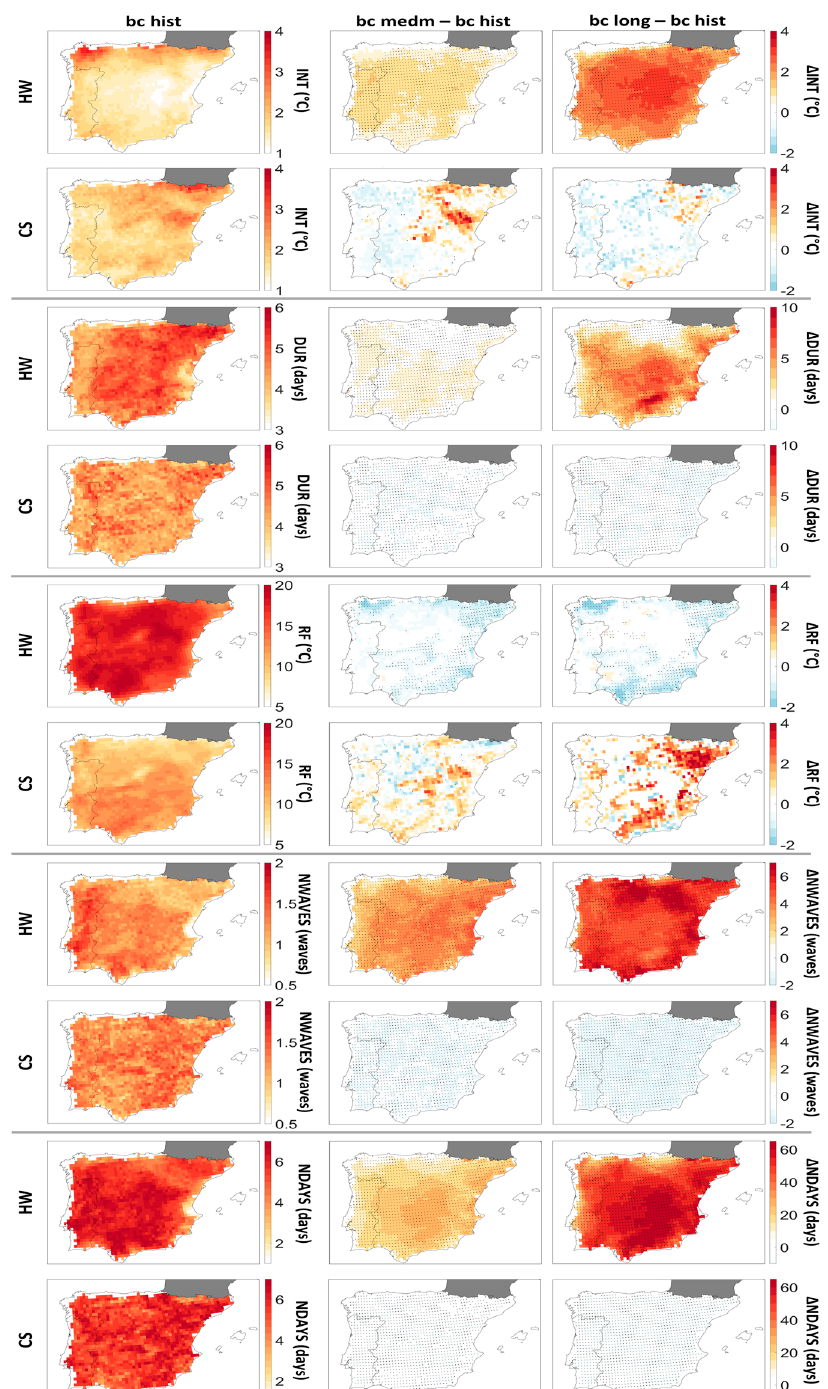
Figure 10. Mean properties—intensity (INT, ◦ C), duration (DUR, days), recovery factor (RF, ◦ C), waves’ / spells’ number (NWAVES), and number of wave / spell days (NDAYS, days)—of the heat waves (HW) and cold spells (CS) for the historical period (bc hist, first column). Di ff erences between the medium- and long-term future and the historical period [bc medm–bc hist (second column) and bc long–bc hist (third column), respectively]. Statistically significant di ff erences (Student’s t -test) at the 5% significance level are represented by black